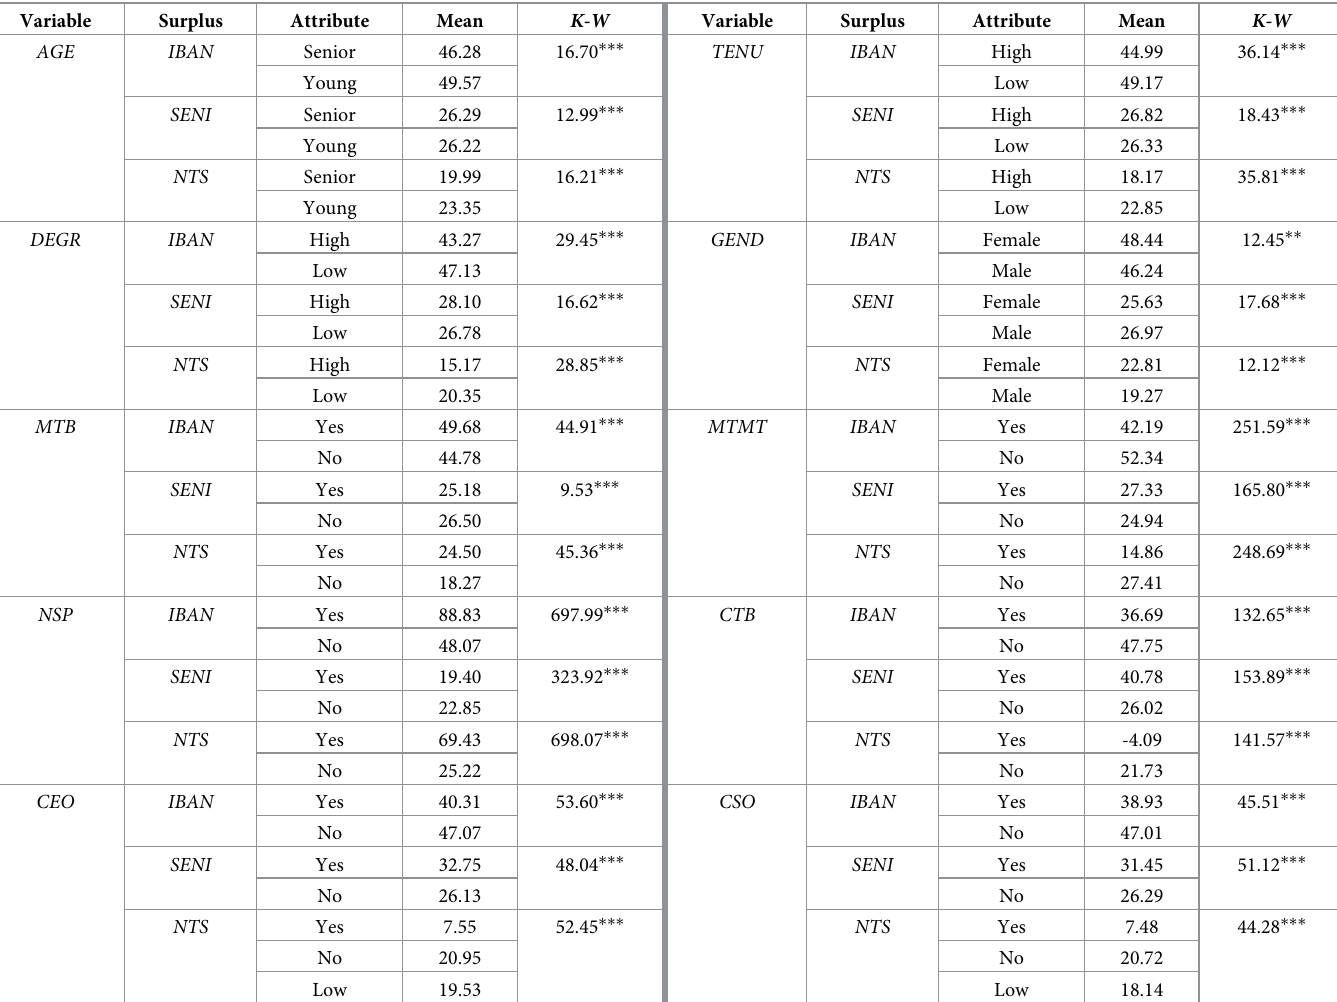
Table 7. Heterogeneity analysis of the bargaining effect based on characteristics of executives. Variable